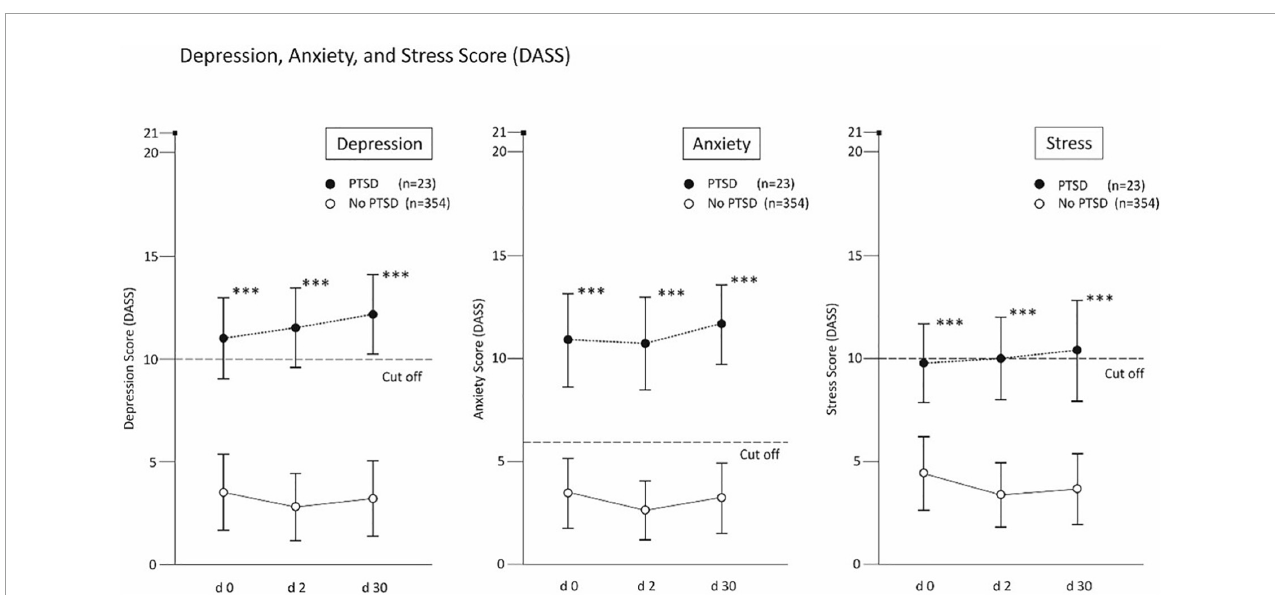
FIGURE4 Results of the depression, anxiety and stress score in cases w/o post-traumatic stress disorder (PTSD). ∗∗ p < 0.01 and ∗∗∗ p < 0.001.